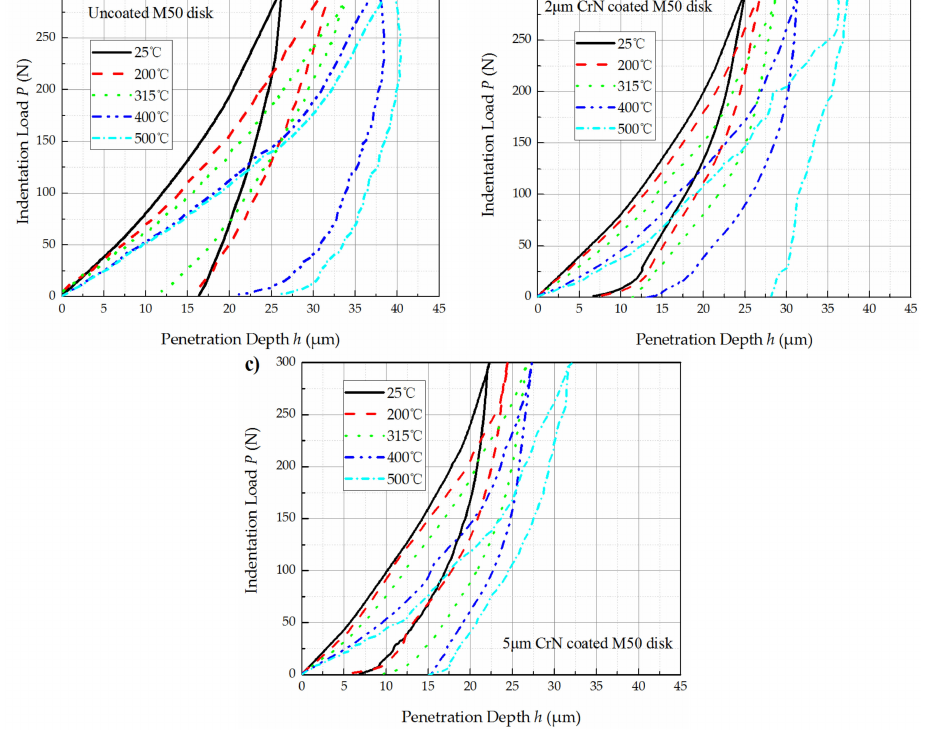
Figure 3. Load–depth curves of the samples as a function of temperatures: ( a ) uncoated M50 disk; ( b ) 2 µ m CrN coated M50 disk; and ( c ) 5 µ m CrN coated M50